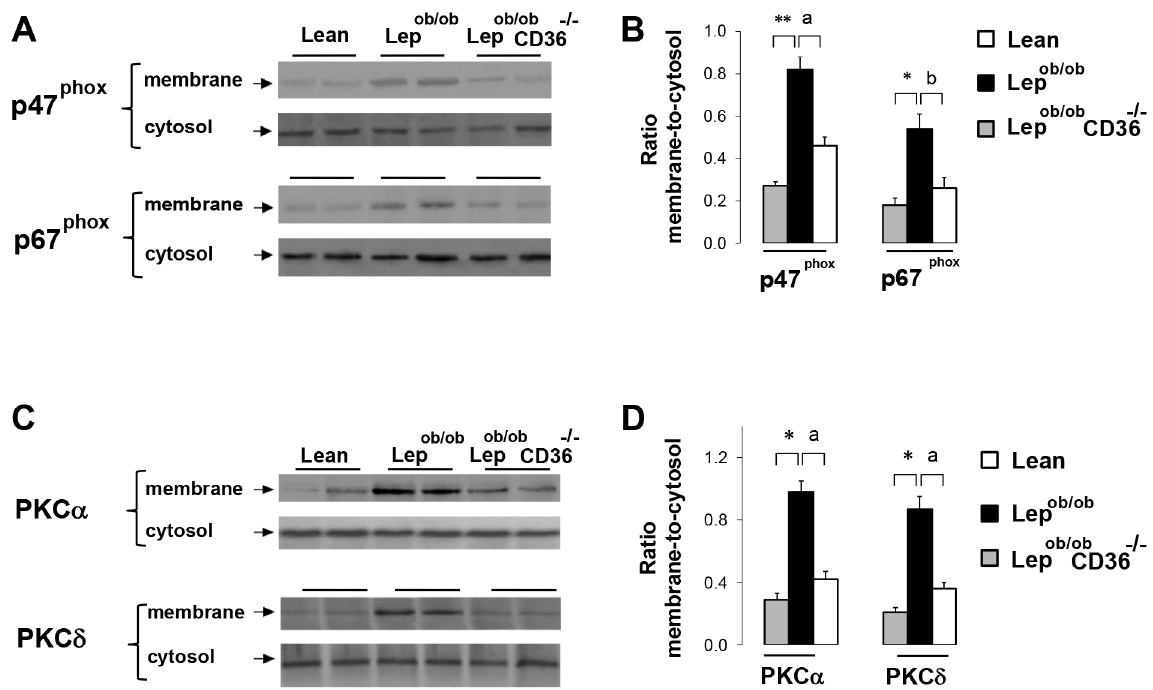
Fig 8. Effects of CD36 expression on the distribution of NADPH oxidase (Nox) and PKC in membrane and cytosol fractions. Representative blots (A and C) and means of membrane-to-cytosol ratios of optic density (B and D) of p47 phox , p67 phox , PKC α and PKC δ proteins. The procedures of separation of membrane and cytosol fractions and western blotting are described in the Methods. Differences between Lep ob/ob and Lean mice are indicated with asterisks with ** p < 0.01 and * p < 0.05, and differences between Lep ob/ob CD36 -/- and Lep ob/ob mice are indicated with alphabetic letters a p < 0.01 and b p <